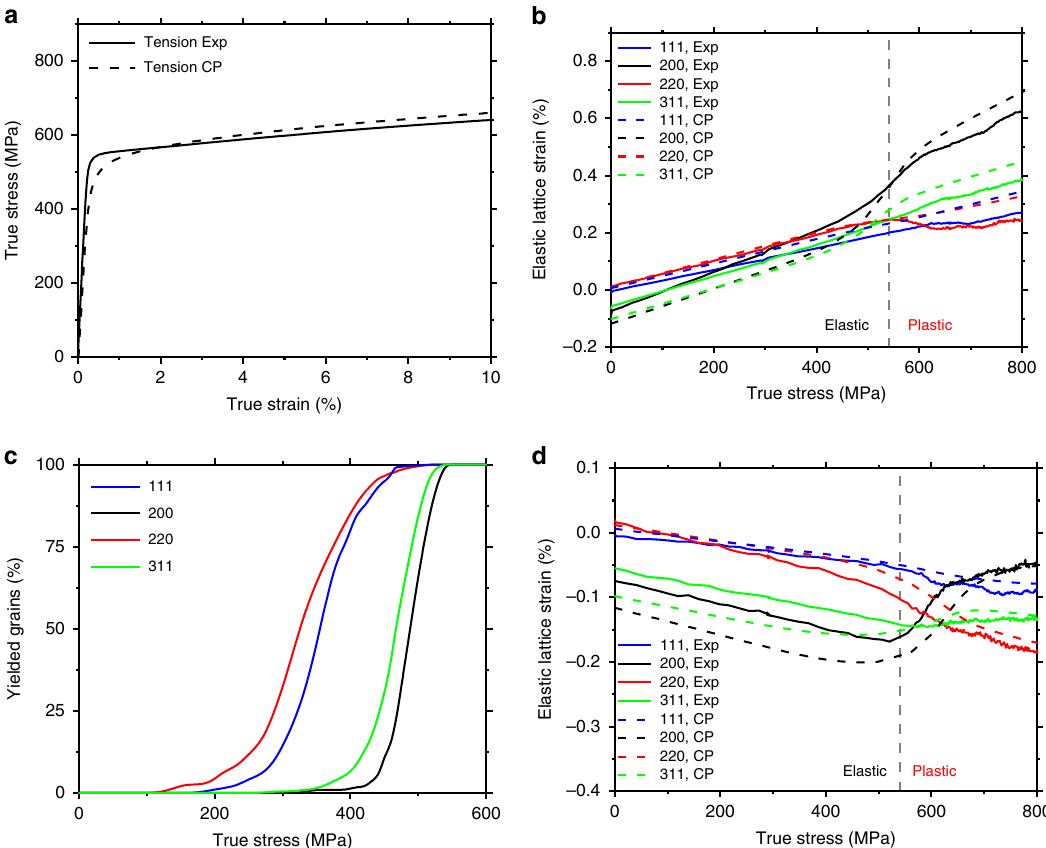
Fig. 5 CPFE simulation results of stress and strain responses in as-printed stainless steel under uniaxial tension. a Comparison of the true stress – strain curves of uniaxial tension from experiment (Exp) and crystal plasticity (CP) fi nite element simulatoin. b Comparison of the lattice strains along LD against the macroscopic true stress for the {111}, {200}, {220} and {311} grain families from experiment and CPFE simulation. c Simulated volume fraction of plastically yielded grains within each family against the macroscopic true stress in the as-printed sample, showing progressive plastic yielding among different grain families. d Same as b , except along